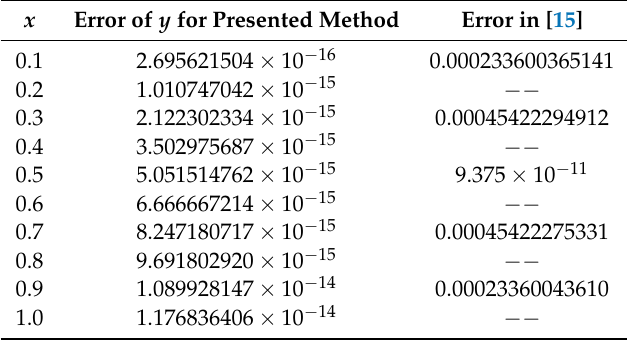
Figure 2. The approximate and exact solution of y ( x ) for Example 2. Table 2. The absolute error of the this method for Example